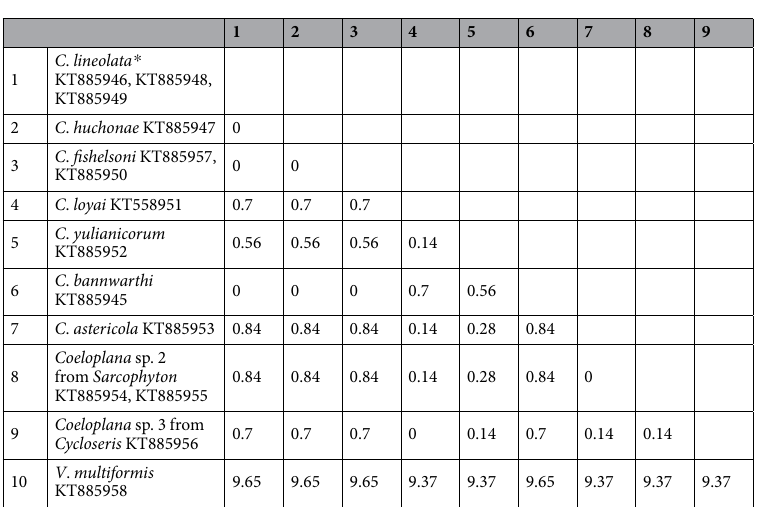
Table 2. 28S rDNA (C1-D2 domain) interspecific sequence divergences ( p -distances) of ctenophore species from the family Coeloplanidae. Each species is represented by a single sequence, except C . lineolata , C . fishelsoni and Coeloplana sp. 2, which are represented by three, two and two individuals, respectively. * C . lineolata and C. punctata were considered to belong to the same